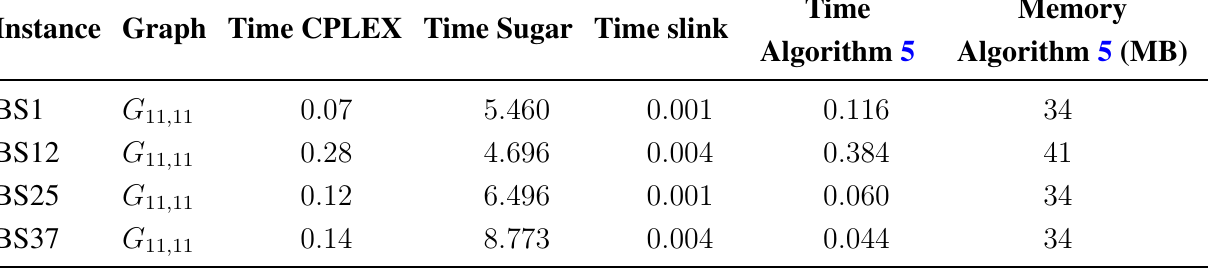
Table 3. Running time in seconds for solving Slitherlink. Our algorithm could not solve C95 due to insufficient